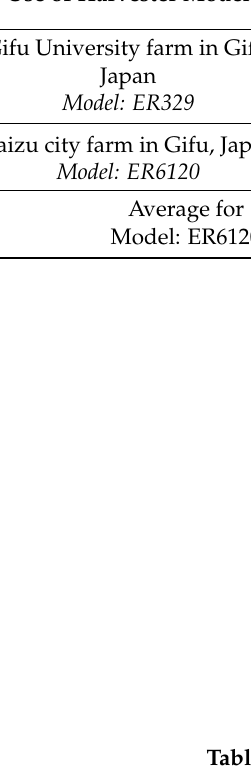
Table 5. Major cost items for a combine operation business in custom-hire